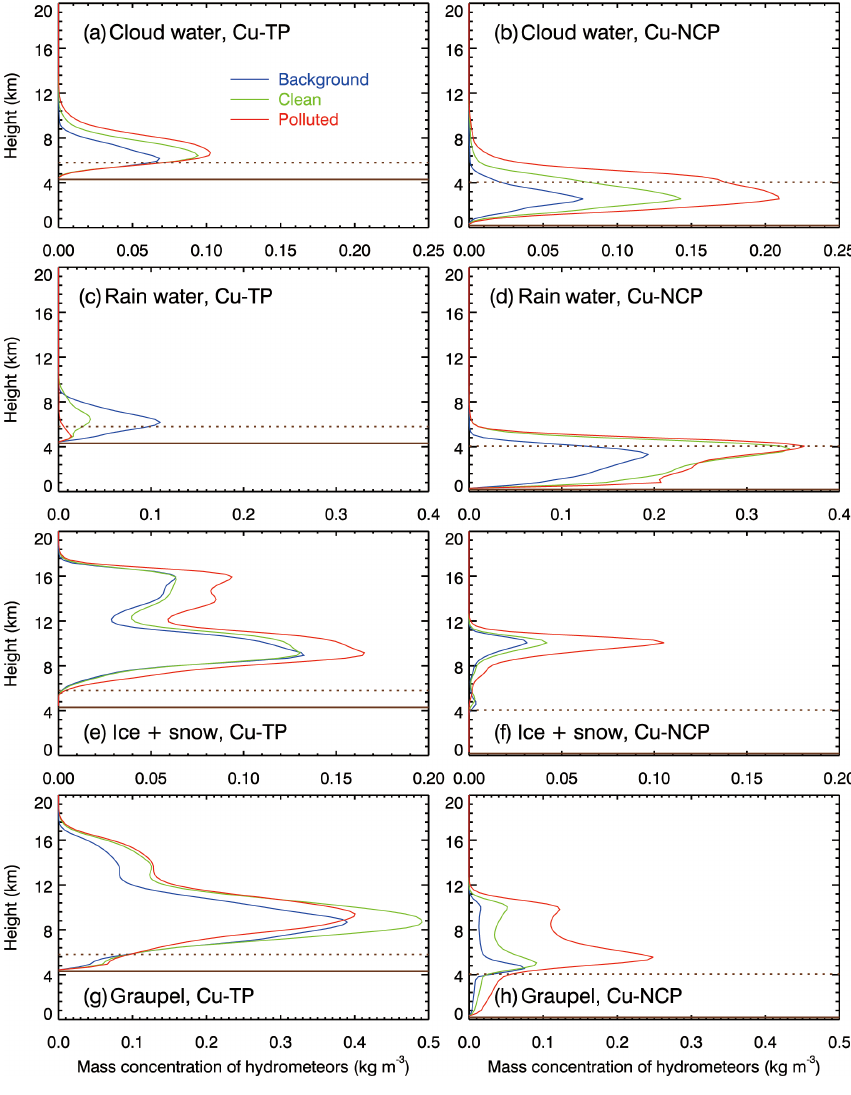
Figure 4. Vertical profiles of time-averaged masses of hydrometeors under background (90cm − 3 , blue), clean (900cm − 3 , green), and polluted (9000cm − 3 , red) [ N a ] conditions for (a, b) cloud water, (c, d) rain water, (e, f) ice particles (ice + snow), and (g, h) graupel in Cu-TP and Cu-NCP, respectively. The brown solid and dotted lines represent the surface level and the 0 ◦ C isotherm,